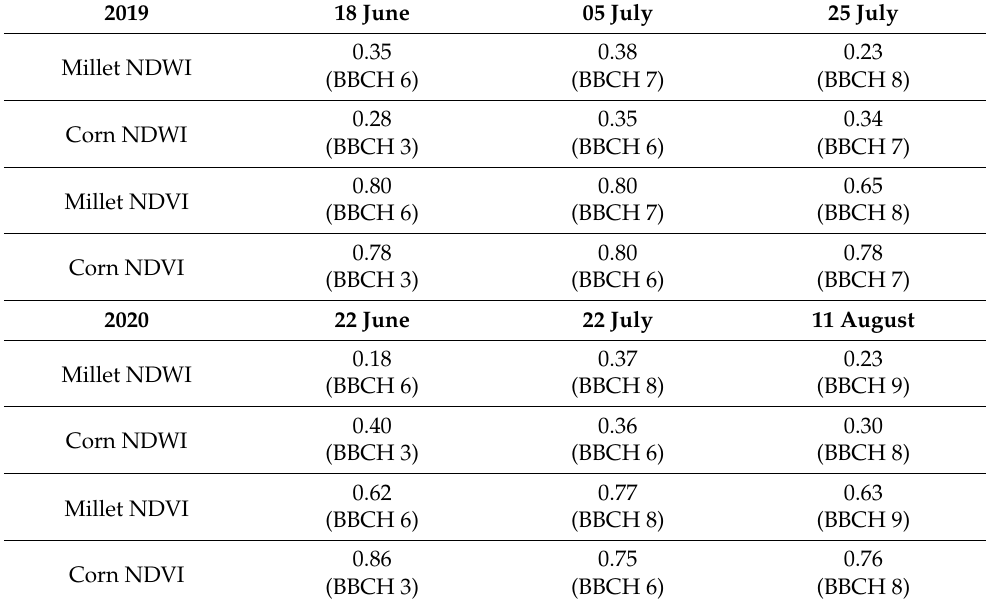
Table 3. Corn (in AC site) and millet (in the VM site) NDVI and NDWI in 2019, 2020, and 2021